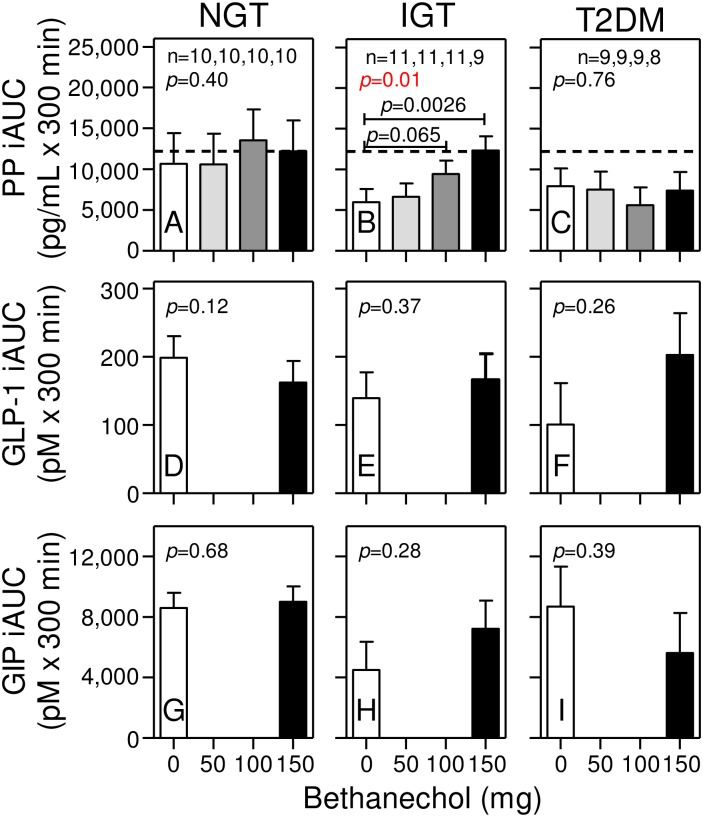
Bethanechol increases the PP iAUC only in humans with IGT.Incremental AUCs were calculated for each individual at the indicated dose of bethanechol from data shown in Fig 3. Group means ± SEM are shown. P values were determined using the mixed effects model. Statistics are as in Fig 4.